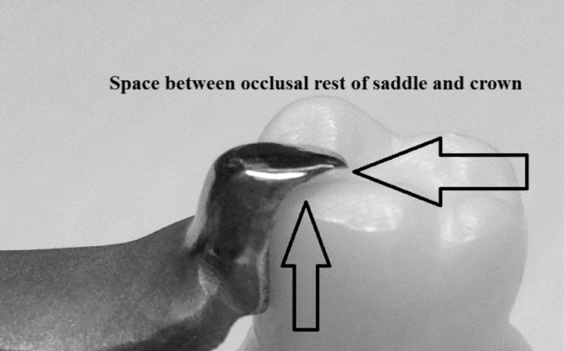
Figure 11. IPS e.max crowns with unfitted occlusal rest of RPD on the prepared area, space between occlusal rest and